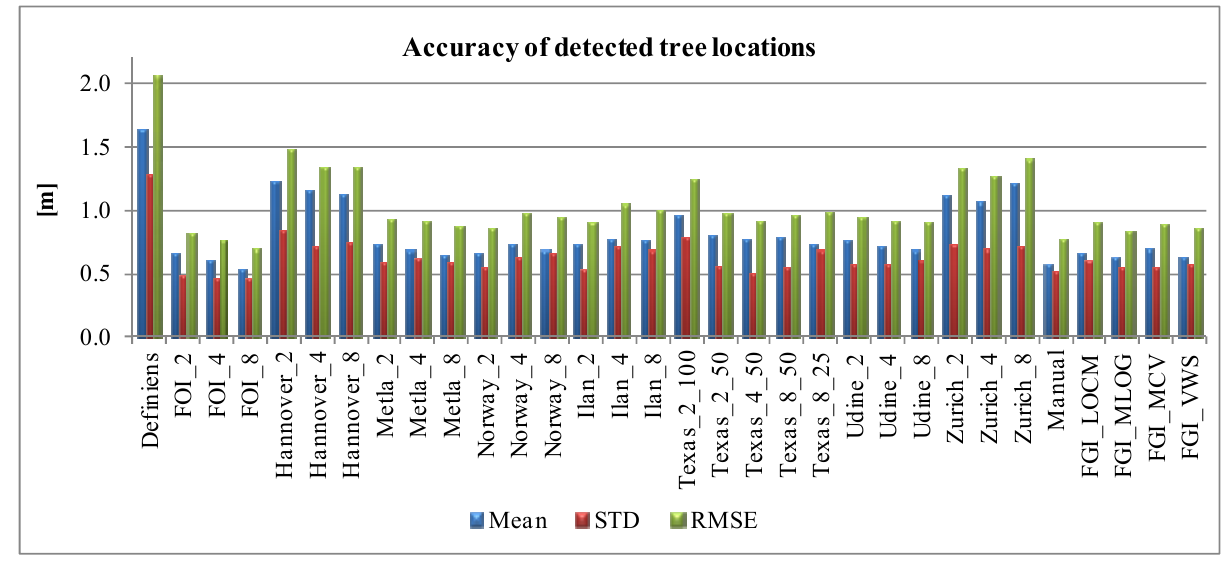
Figure 7. Accuracy of detected tree locations.